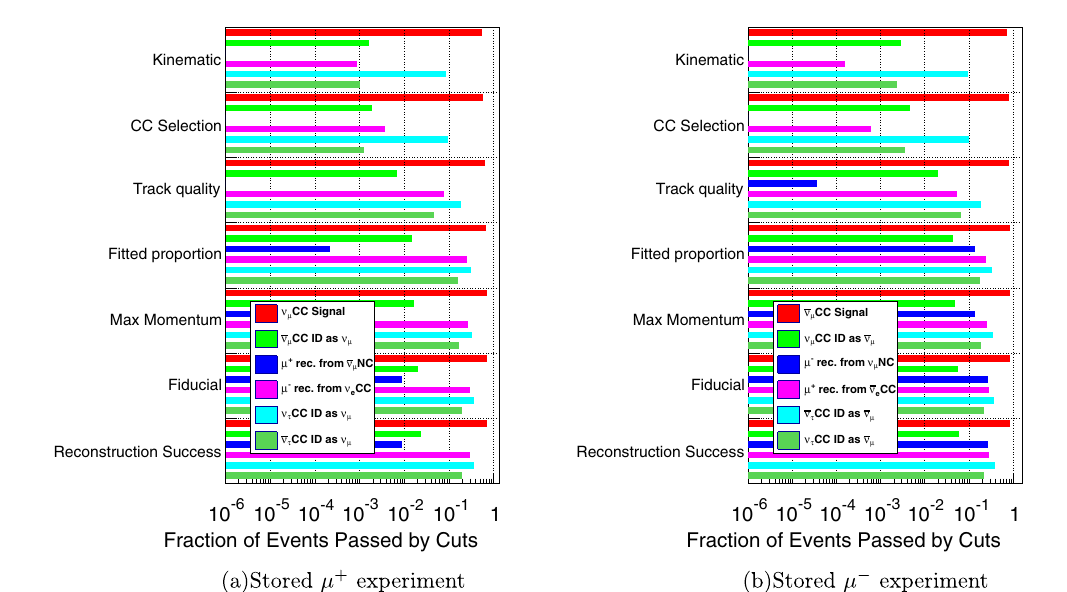
FIG. 7. Effect of the cuts on the detection of signal and background events assuming a magnetic field that focuses positively charged